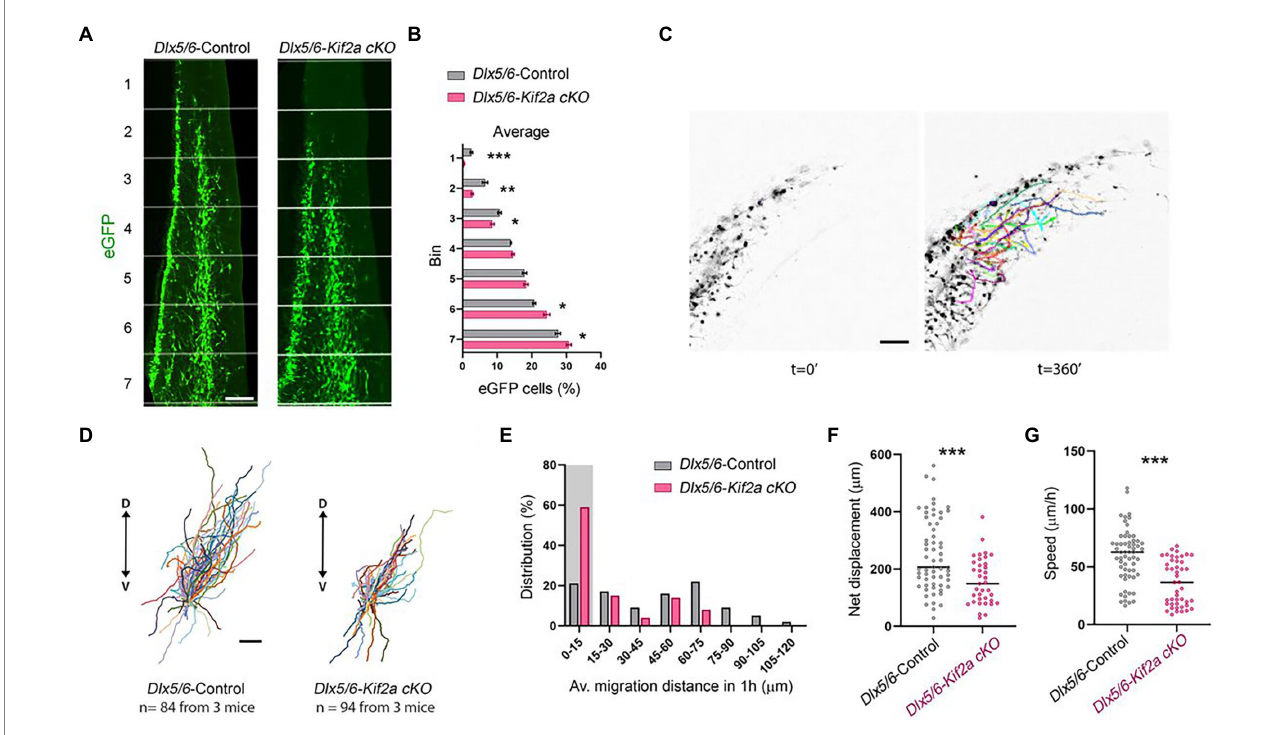
FIGURE 3 Cell-autonomous requirement of KIF2A for interneuron migration. (A) Distribution of Dlx5/6-Cre-eGFP-positive interneurons in 7 equal bins along the migratory pathway at E13.5. (B) Percentage of cells in each bin for control and Dlx5/6-Kif2a cKO mice (control n = 4 and Dlx5/6-Kif2a cKO n = 6 embryos). (C) Representative time lapse sequence illustrating tracking of interneurons in control and Dlx5/6-Kif2a cKO mice. (D) Schematic illustration of migratory trajectories starting from the center. (E) Distribution of interneurons by migrated distance in control and Dlx5/6-Kif2a cKO mice (control n = 81, Dlx5/6-Kif2a cKO n = 92 from 3 different embryos each genotype). The shaded area depicts stationary interneurons (0–15 μ m), which were removed from further analysis. (F) Net displacement in control and Dlx5/6-Kif2a cKO mice (control: 251 ± 16.4 μ m, n = 61; Dlx5/6-Kif2a cKO : 157.9 ± 13.4 μ m n = 34 from 3 different embryos each genotype). (G) Speed in control and Dlx5/6-Kif2a cKO mice (control: 59.37 ± 3 μ m, n = 60; Dlx5/6-Kif2a cKO : 36.22 ± 2.9 μ m n = 45 from 3 different embryos each genotype). Scale bars (A,C,D) 100 μ m. Data are represented as mean ± SEM. Values were obtained by unpaired Student’s t-test (B) or Mann- Whitney test (F,G) ; * p < 0.05, ** p < 0.01, and *** p <